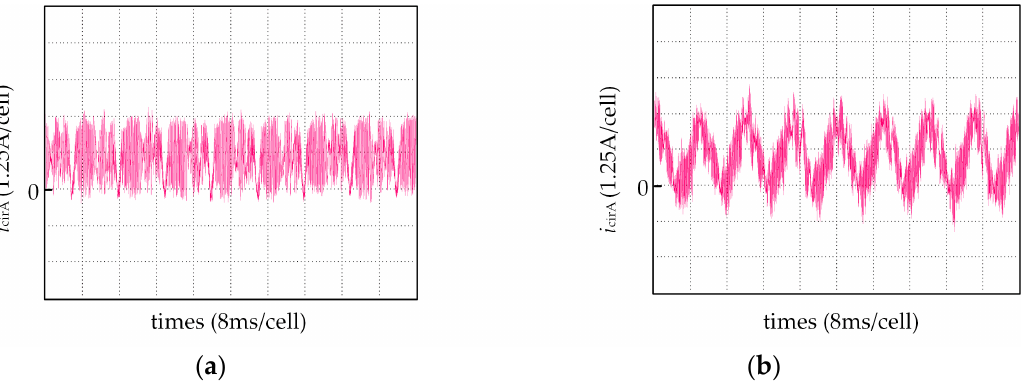
Figure 21. Experimental waveform of the circulating current fluctuation at cos φ = 0.623 ( N = 4). ( a ) The proposed modulation method, ( b ) the conventional modulation method.